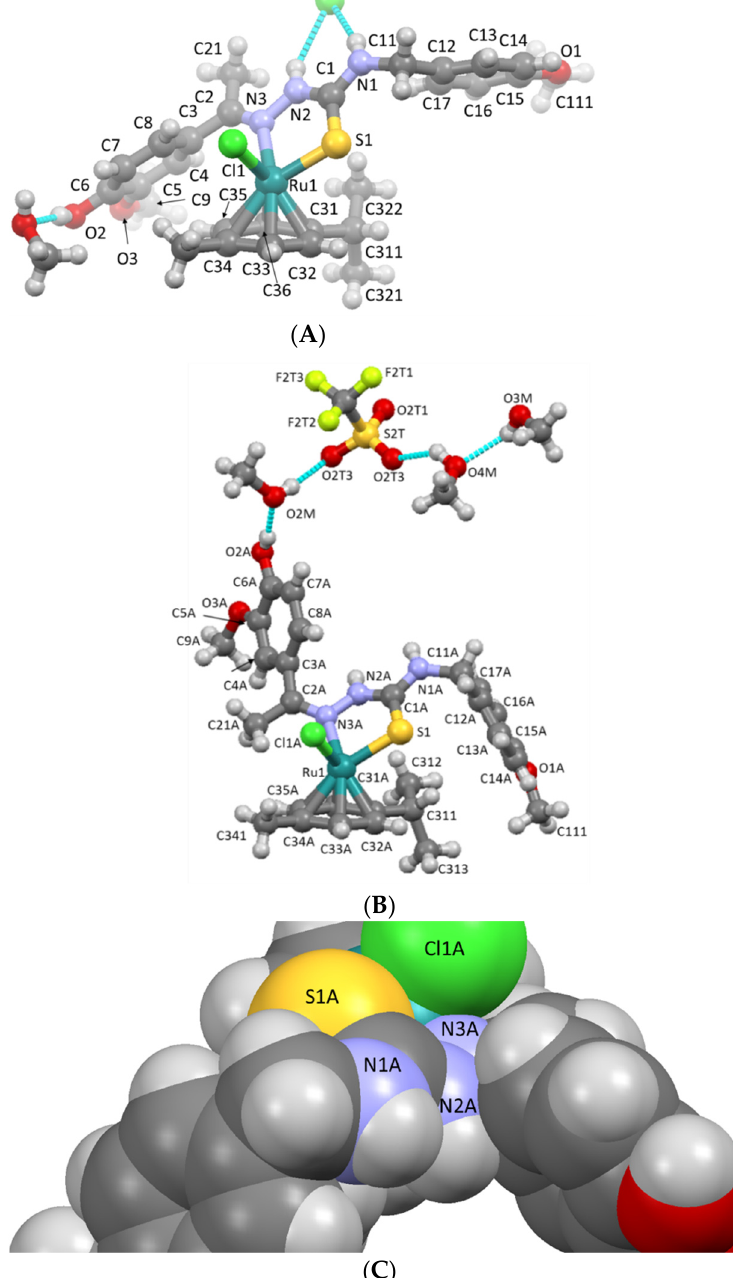
Figure 2. ( A ) The asymmetric unit in the structure of 1(Cl) .CH 3 OH. ( B ) representation of one of the molecules of complex observed in 1(TfO) .2(CH 3 OH), showing the H-bonding between ions and solvent molecules. ( C ) Space-filling model of the molecule of 1(TfO), showing that the Z configuration of the C2=N3 bond hinders the H-bonding role of the groups N1–H, in particular N2–H. In the structures of both cations 1 + , the ligand HL 1 is coordinated to ruthenium by the sulfur atom and the nitrogen N3 to form a five-membered chelate ring. The pseu- do-octahedral (piano stool-shaped) coordination around the ruthenium atom is com- pleted by the para -cymene ring and the chloride ligand. In order to achieve κ 2 - S , N3 coordination, the conformation of the N2–C1 bond in the ligand must change from E , as observed in the free ligand, to Z ; in the determination of the conformers of the complexes, the metal–ligand binding is ignored. However, an in- teresting difference between the two cations is the conformation of the C2=N3 bond of the HL 1 ligand. In the chloride derivative the configuration of this bond is E , which directs the vanillin ring towards the ruthenium atom (Figure 2A); however, in the crystal struc- ture of the triflate derivative the conformation is Z , and the methyl group is oriented towards the metal (Figure 2B). This arrangement explains the differences in the Ru–S1 and Ru–N3 distances observed in the two compounds: the former is clearly shorter, while the latter is clearly longer in the chloride than in the triflate. Bearing in mind the greater steric hindrance that the vanillin ring must impose, it stands to reason that the approach of the HL 1 ligand must be facilitated by the more distant sulfur. This proposal is sup- ported by the C1–S1–Ru1 angle in the E -isomer, as observed in 1(Cl) , which is wider than in the Z -isomer observed in 1(TfO) . Similarly, the S1–Ru1–N3 chelate angle is wider in the chloride derivative (82.30(4)°) than in the triflate (80.99(12) and 81.09(12)°).